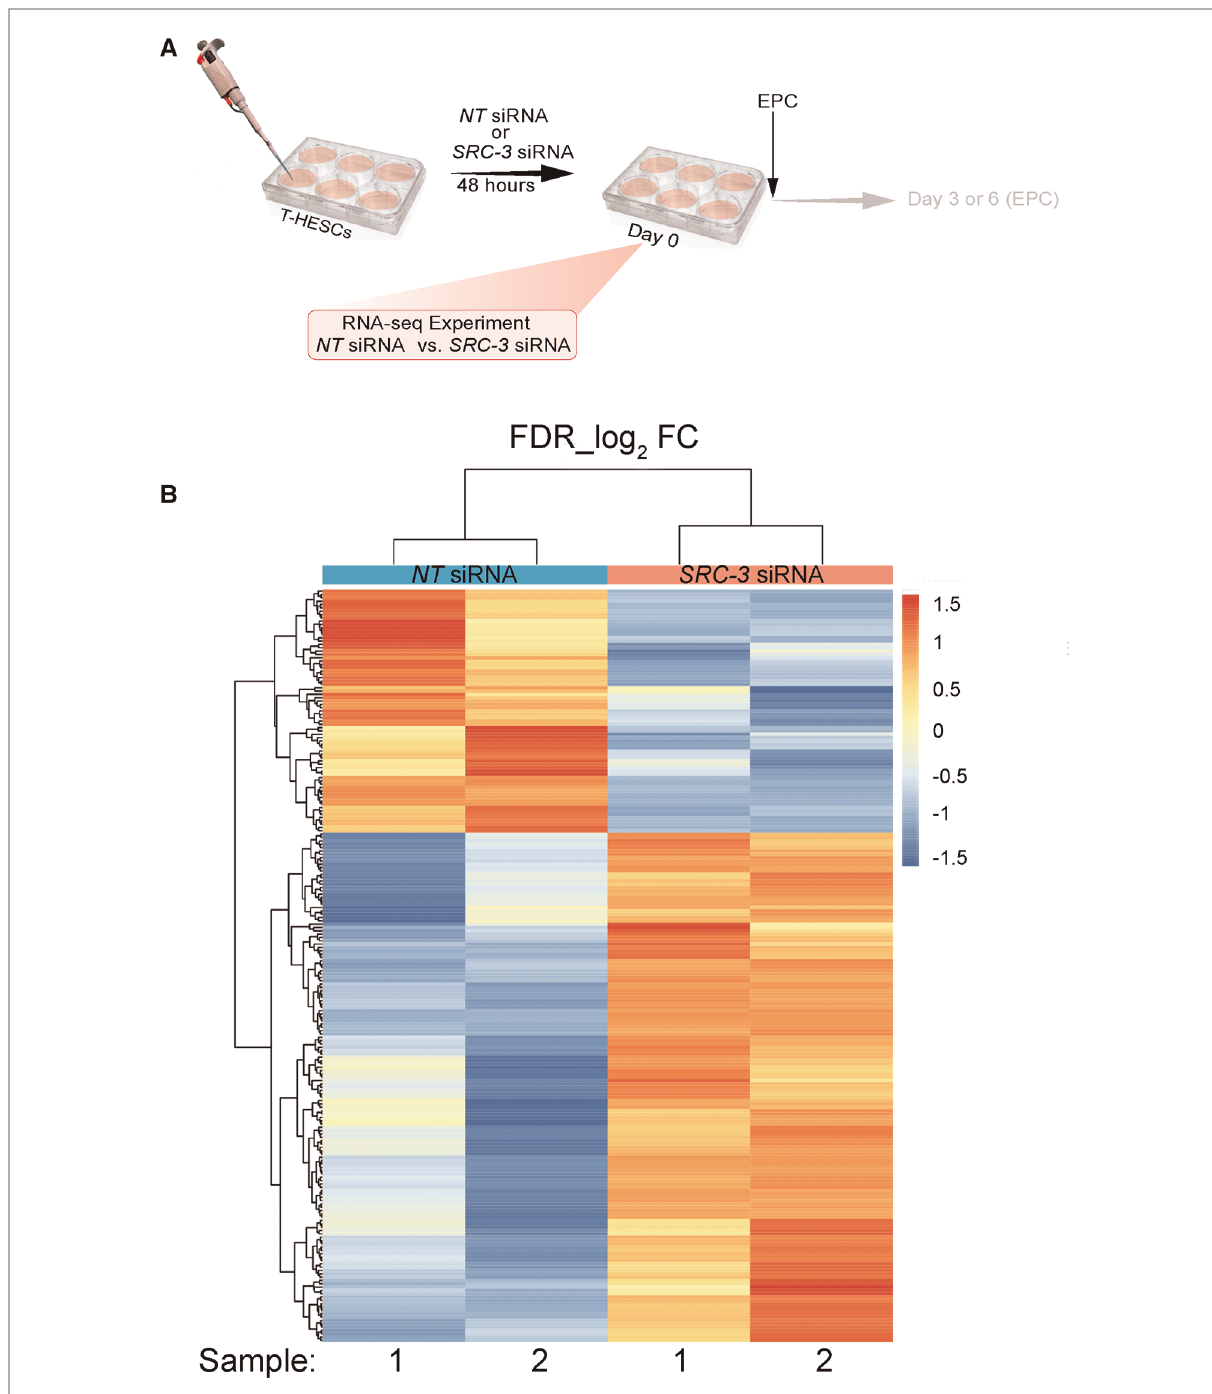
FIGURE 5 The SRC-3 dependent transcriptome in T-HESCs prior to receiving the deciduogenic hormone stimulus ( A ) the experimental design of the RNA-seq experiment showing that T-HESCs were transfected with NT or SRC-3 siRNAs for forty-eight hours prior to being harvested for total RNA isolation; note: T-HESCs did not receive the EPC medium. Cells were harvested from two wells of a six well plate for each replicate; two replicates per NT and SRC-3 siRNA treatment group were used for these RNA-seq experiments. ( B ) Heatmap of clustered genes with the same expression level differentially expressed (up or down) between the NT siRNA and SRC-3 siRNA groups. Using a FDR <0.05 and an IFCI>1.5 cutoff, 226 genes were differentially expressed (73 down and 153 up) between the NT and SRC-3 siRNA groups. The 226 genes were clustered and displayed as a heat map, in which each horizontal row represents a single gene. Warmer and cooler colors ( i.e. reds and blues respectively) represent higher and lower expression respectively: the vertical color key on the right indicates the color intensity with normalized expression